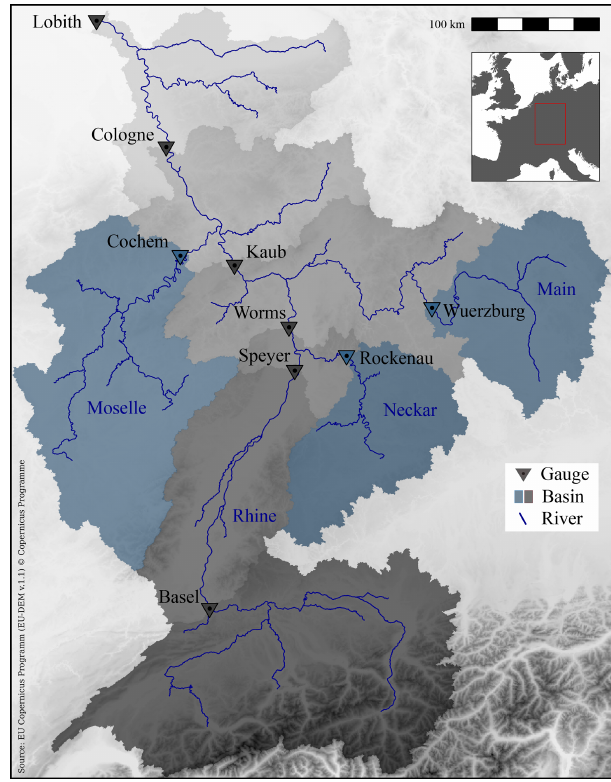
Figure 2. Topographic map of the Rhine River basin at the gauge at Lobith with locations of all gauges and sub-basins